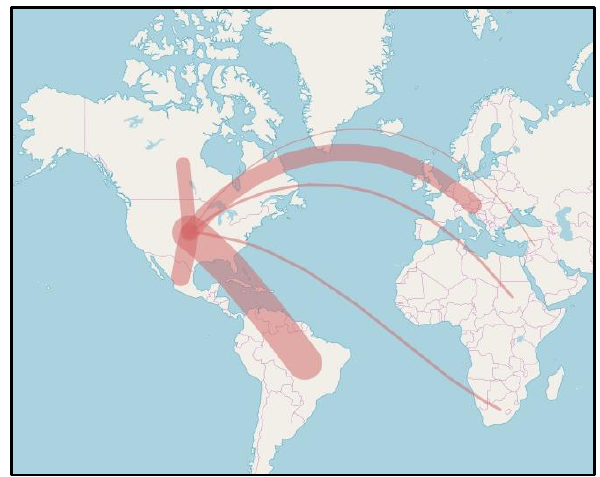
Figure 13. Export of Refined Products from USA.